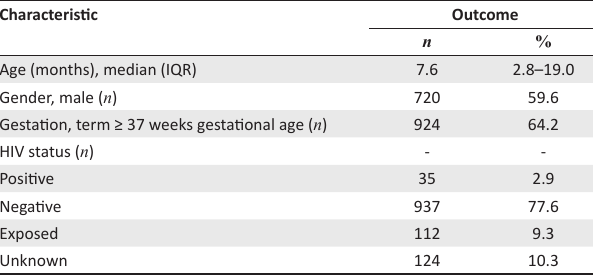
TABLE 1: Demographic characteristics of the included